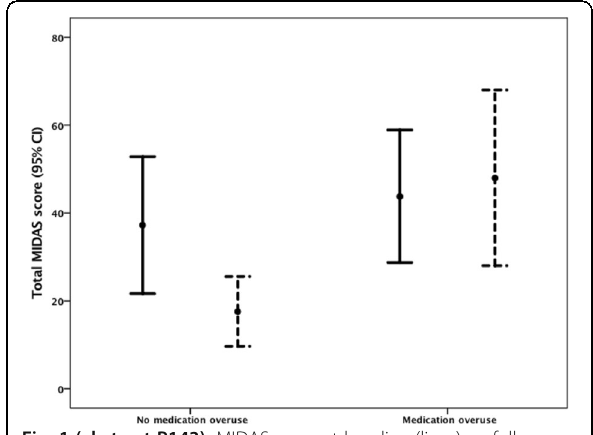
Fig. 1 (abstract P143). MIDAS score at baseline (lines) vs. follow-up (dashed) of participants with/without medication overuse at follow- up. (All had medication overuse at